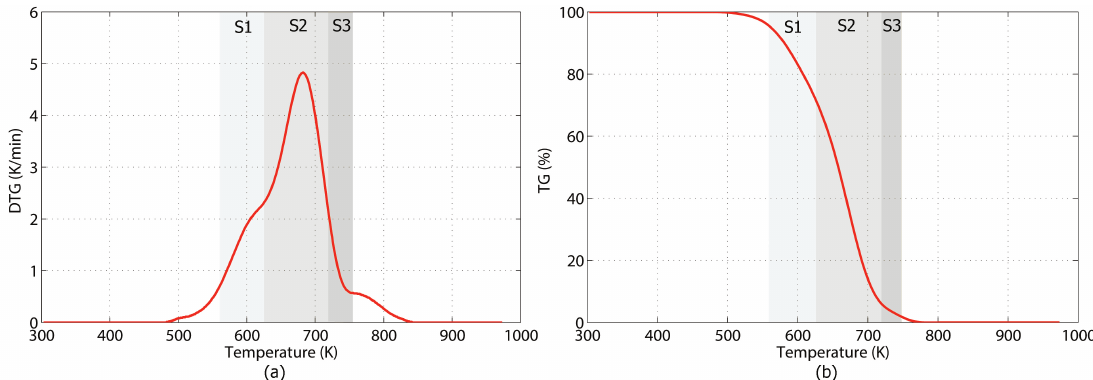
Figure 2. Thermal decomposition process of the animal fat sample at 5 K · min − 1 : ( a ) differential thermogravimetric (DTG) curve, and ( b ) thermogravimetric (TG)